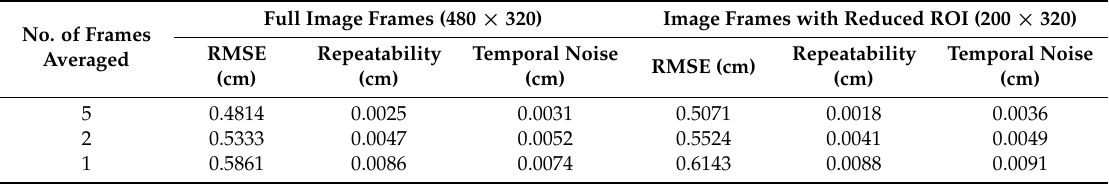
Table 7. Accuracy and precision for LP LED at the